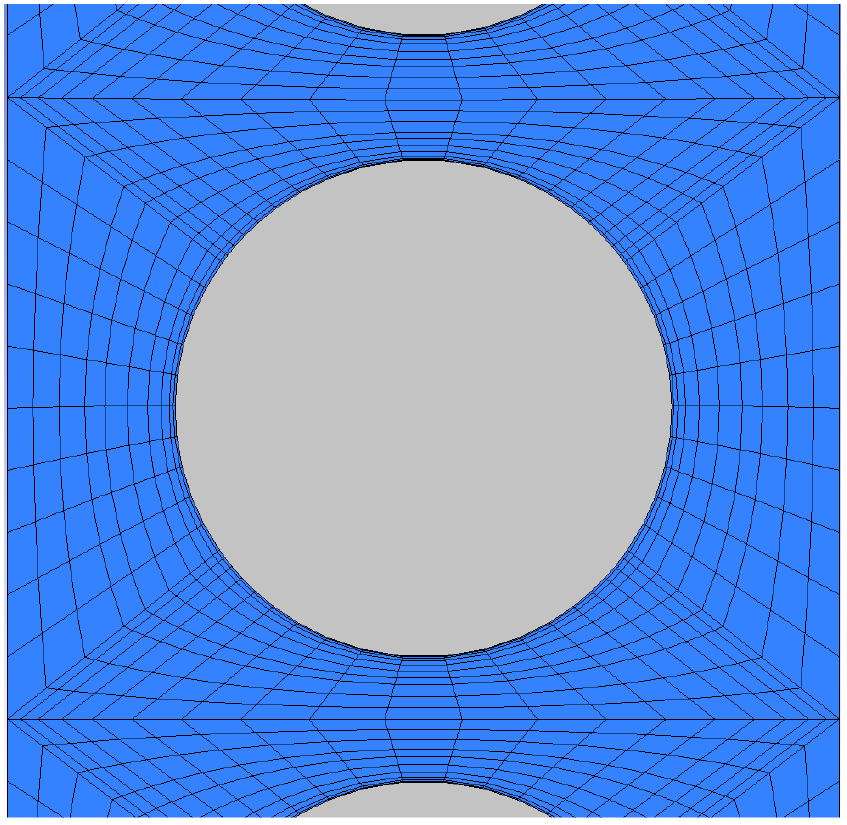
Figure A2. Top view of the CFD mesh around the drum.